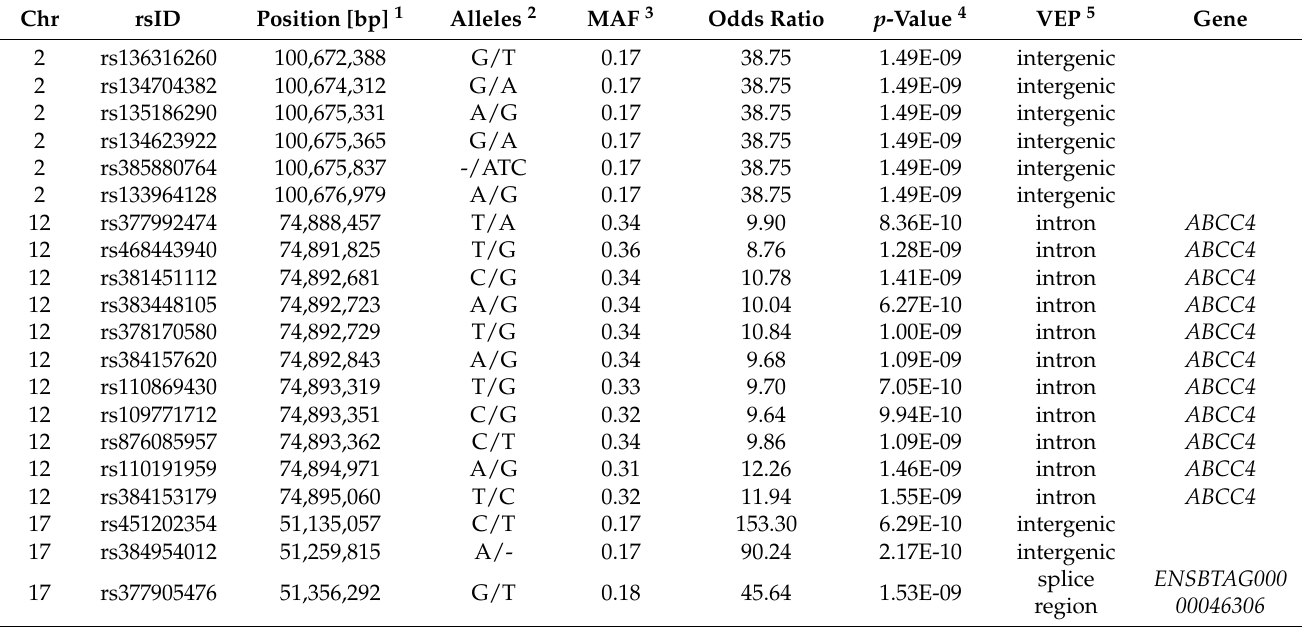
Table 1. Top 20 of the genome-wide significantly associated variants (P Bonf ≤ 0.05). Bold lines indicate associations with P Bonf ≤